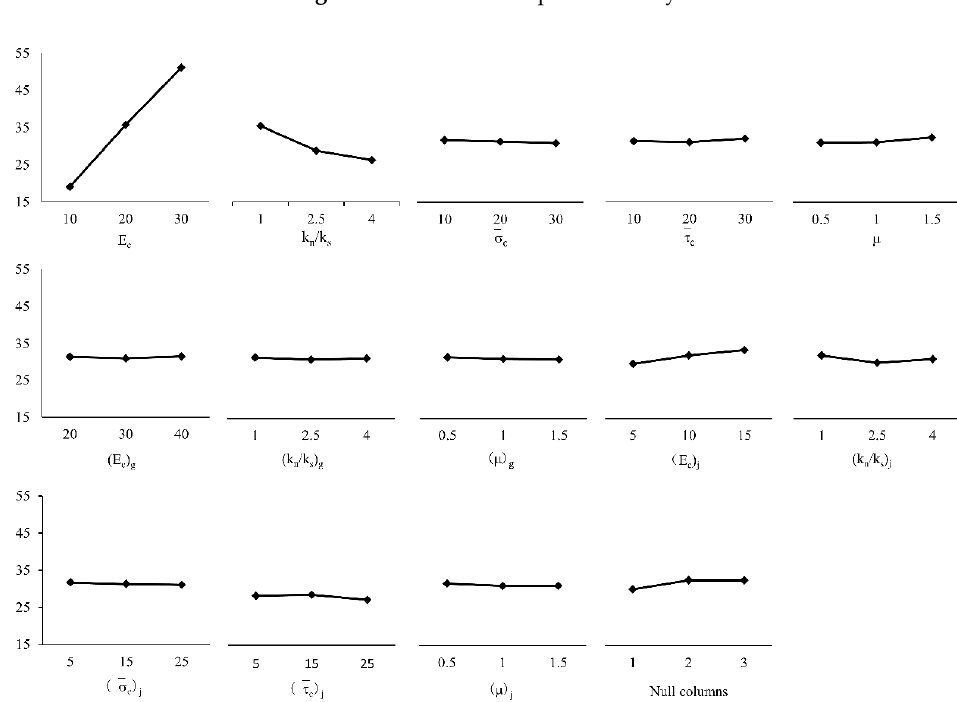
Figure 6. Mean modulus of elasticity.